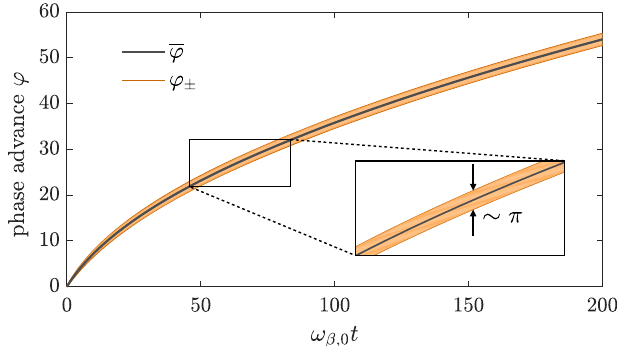
FIG. 1. Illustration of the phase advance of electrons within a beam slice. The gray curve depicts the mean slice phase advance ¯ φ and the orange curves illustrate the phase advance φ according to Eq. (5) for electrons with an energy deviation of (cid:3) δγ (for this illustration, ϵ ¼ 0 . 3 and δγ ¼ 0 . 3¯ γ 0